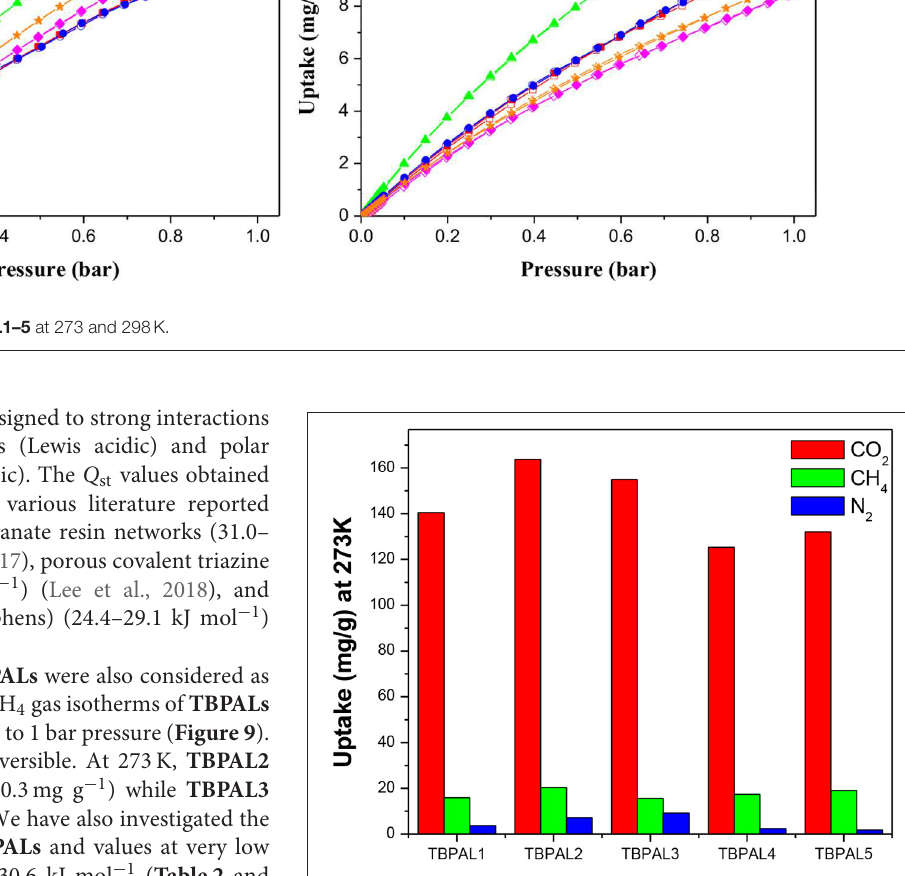
FIGURE 10 | Gas (CO 2 , CH 4 and N 2 ) uptake diagram of TBPAL1–5 at